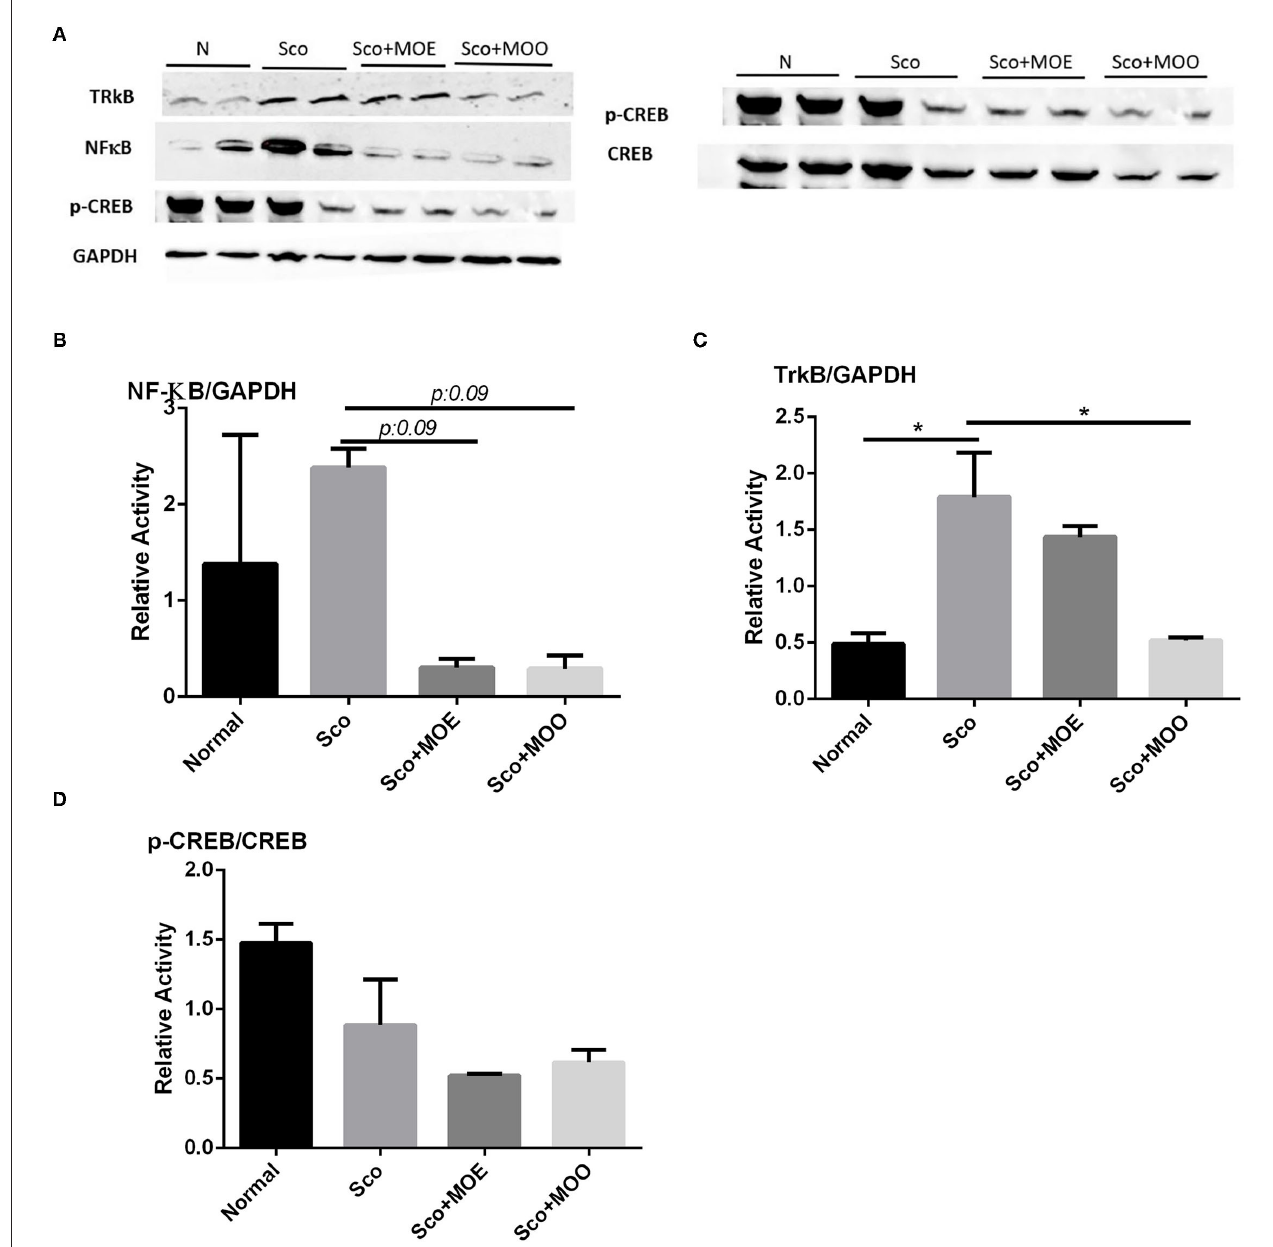
FIGURE 5 | (A) Representative western blot gel in the hippocampus tissue of tropomyosin receptor kinase B (TrkB), nuclear factor-kappa-light-chain-enhancer of activated B cells (NF- κ B), p- cAMP-response element-binding (CREB), CREB, and glyceraldehyde 3-phosphate dehydrogenase (GAPDH). (B) Quantified band analysis of NF- κ B protein expression. Quantified result were normalized to GAPDH expression. Each column represents mean ± SEM of six mice. Data analysis was performed using one way ANOVA, followed by Tukey’s multi comparison test. MOE, aqueous leaves exctract of M.oleifera ; MOO, M.oleifera seed oil. (C) Quantified band analysis of TrkB protein expression. Quantified result were normalized to GAPDH expression. Each column represents mean ± SEM of six mice. * p < 0.05. MOE, aqueous leaves exctract of M.oleifera ; MOO, M.oleifera seed oil. (D) Quantified band analysis of p-CREB protein expression. Quantified result were normalized to CREB expression. Each column represents mean ± SEM of six mice. MOE, aqueous leaves exctract of M.oleifera ; MOO, M.oleifera seed